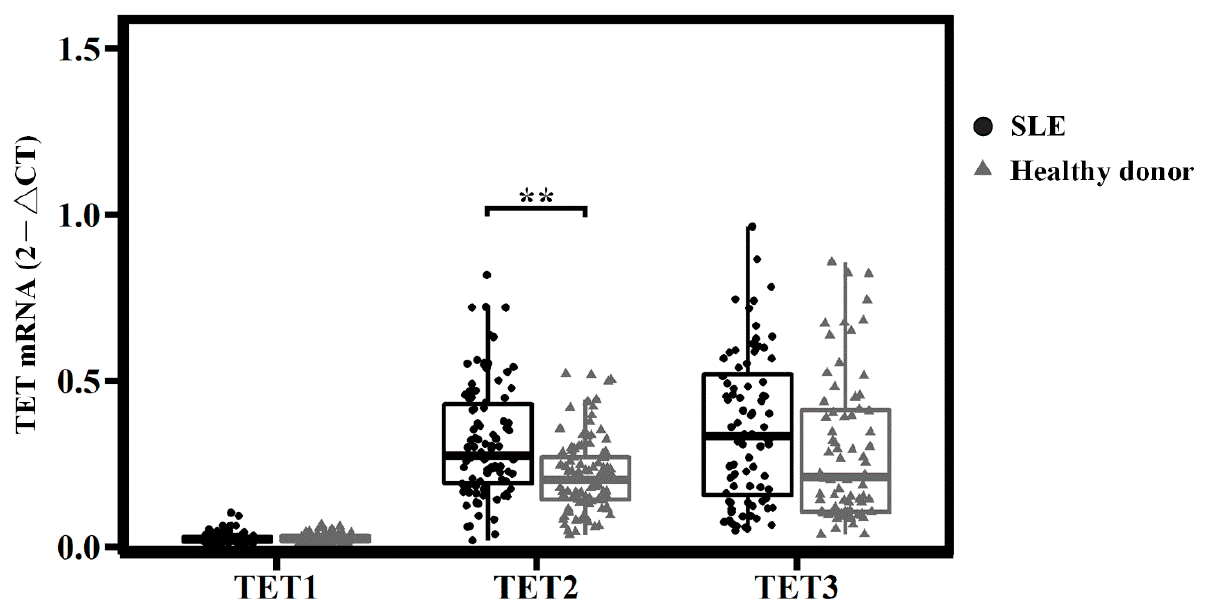
Figure 1. mRNA expression of TETs in systemic lupus erythematosus and healthy donors. TET2 was remarkably high in SLE, ** p < 0.001. P -values were obtained using ANOVA tests.